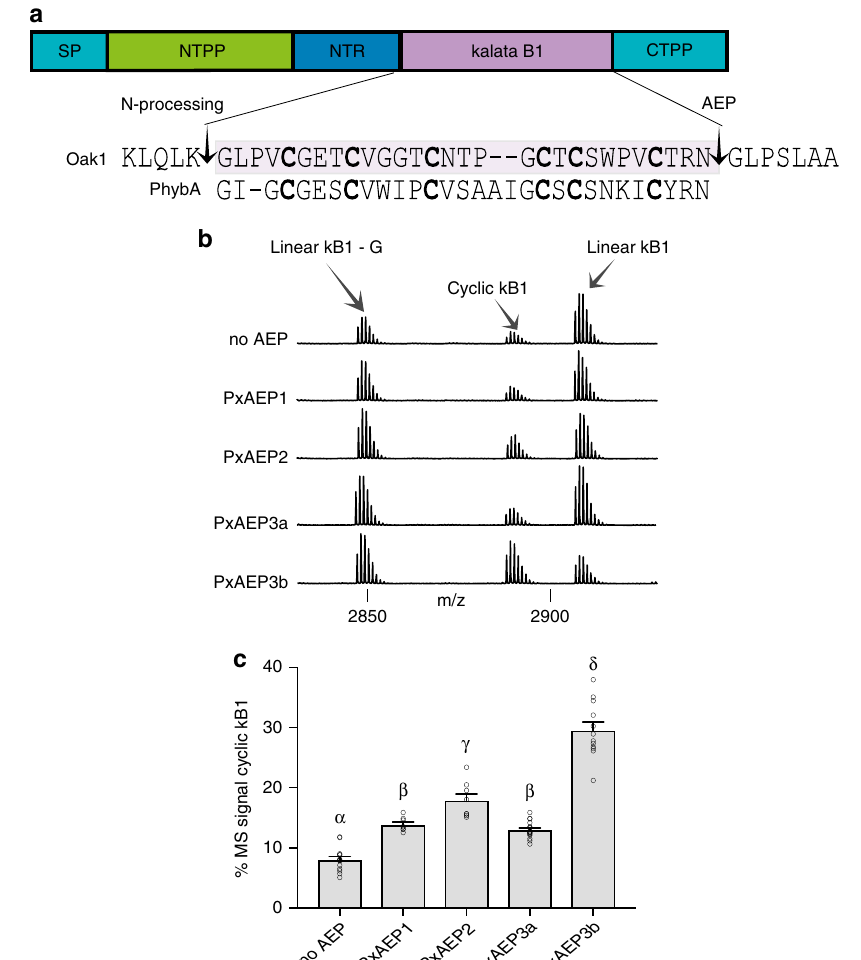
Fig. 1 Petunia AEP isoform PxAEP3b functions as a ligase in planta. a Gene structure of Oak1 , which encodes the prototypic cyclotide kB1 of O. af fi nis 26 . For maturation, the kB1 precursor is directed initially to the endoplasmic reticulum due to the presence of a signal peptide (SP). Here the precursor protein folds and disul fi de bridges are formed. Further traf fi cking towards the vacuole facilitates resident proteases to release the amino terminal propeptide (NTPP) and amino terminal repeat (NTR). The liberation of the kB1 N-terminus is a pre-requisite for AEP-mediated backbone cyclization 52 . Shaded in purple is the 29 aa, six-cysteine containing kB1 peptide sequence. Flanking residues within the NTR and carboxyl terminal propeptide (CTPP) important for post-translational processing are shown. Aligned to kB1 is the Phyb A cyclotide from petunia, which could not be detected in N. benthamiana leaves despite co-expression of petunia AEP isoform PxAEP3b. Although similar in sequence, kB1 and Phyb A differ in topology with the presence of a cis-proline in kB1 leading to a conceptual twist in the cyclic backbone. b Representative MALDI-MS of kB1-related peptides produced upon transient gene expression in N. benthamiana leaves of Oak1 with or without co-expression of petunia AEP genes. c Mean and s.e.m of the percent MS signals obtained for cyclic kB1 over the total MS signal of all kB1-related peptides. Treatments carrying unique Greek lettering are signi fi cantly different ( P < 0.05) as determined by Tukey ’ s ANOVA. Replicates are as follows: n = 14 (No AEP), n = 8 (PxAEP1 and PxAEP2), n = 16 (PxAEP3a) and n = 12 (PxAEP3b). Error bars are